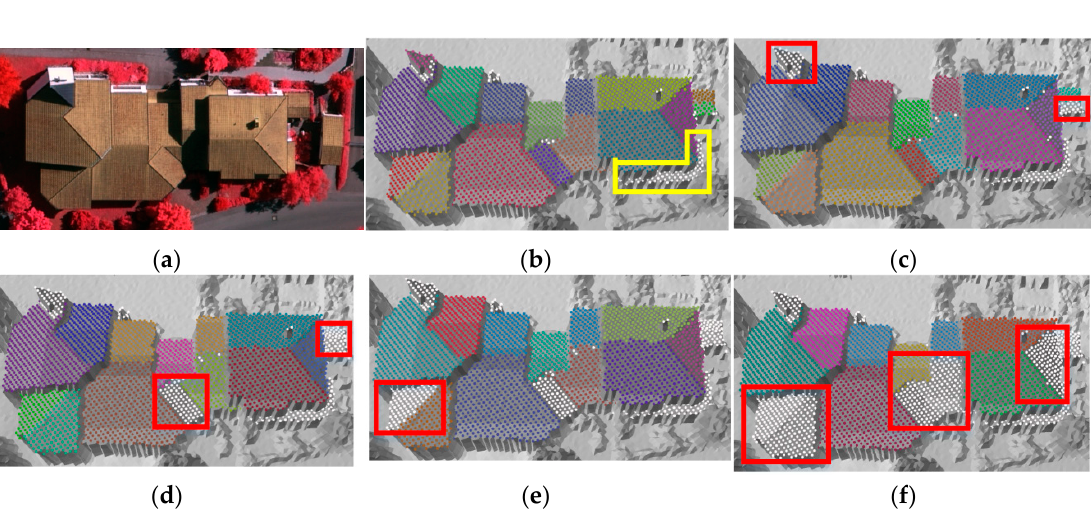
Figure 19. The influence of min line length. ( a ) Corresponding image; ( b ) l = 1.8 m, a narrow plane is missed; ( c ) l = 3.0 m, small planes are missed; ( d ) l = 4.2 m, more small planes are missed; ( e ) l = 6 m, a large plane is missed; ( f ) l = 7.2 m, more large planes are missed.